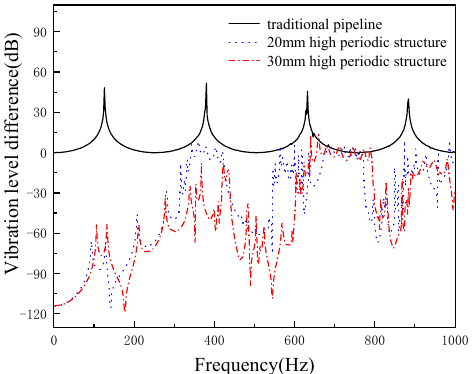
Figure 17. The effects of periodic structure height on cushioning performance (periodic structure